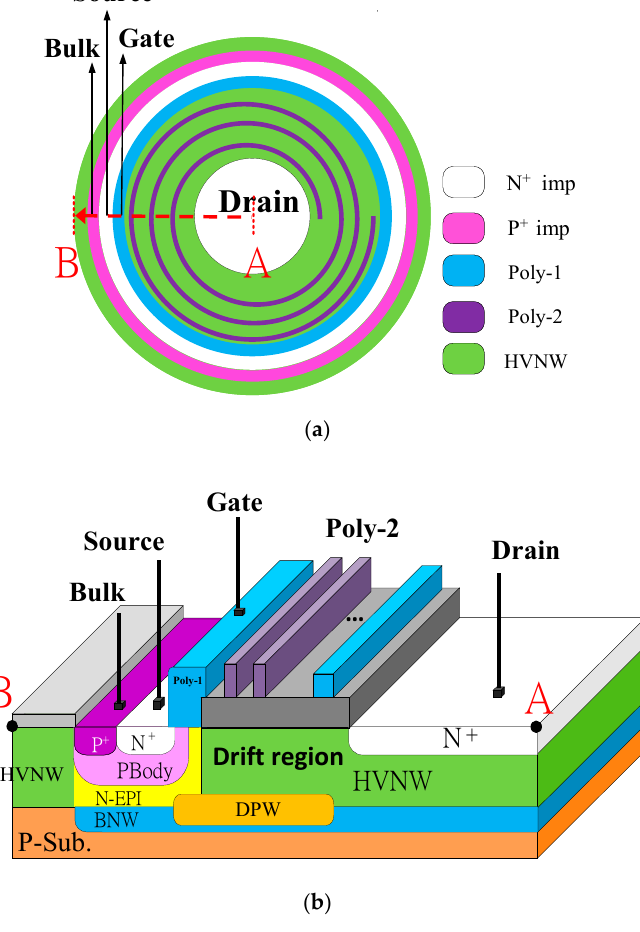
Figure 3. ( a ) Device layout diagrams, and ( b ) 3-D structure view of the UHV 300 V circular LDMOS ref. device.